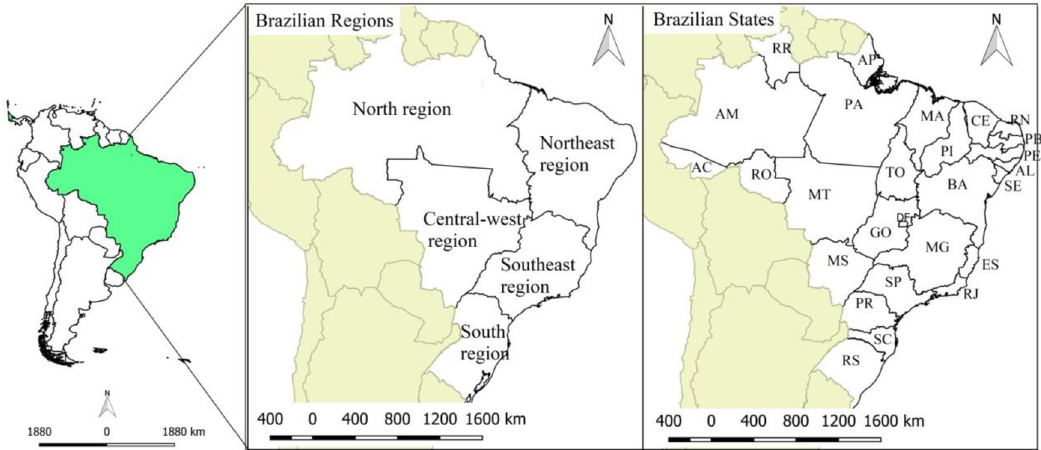
Fig 1. Geographical location of the study area. Map base layers were obtained from < http://www.naturalearthdata.com/about/ terms-of-use/ > covered by a Creative Commons Attribution 4.0 International (CCBY) License (https://creativecommons.org/ licenses/by/4.0/legalcode). Map base layers were modified in QGIS software version 2.18.